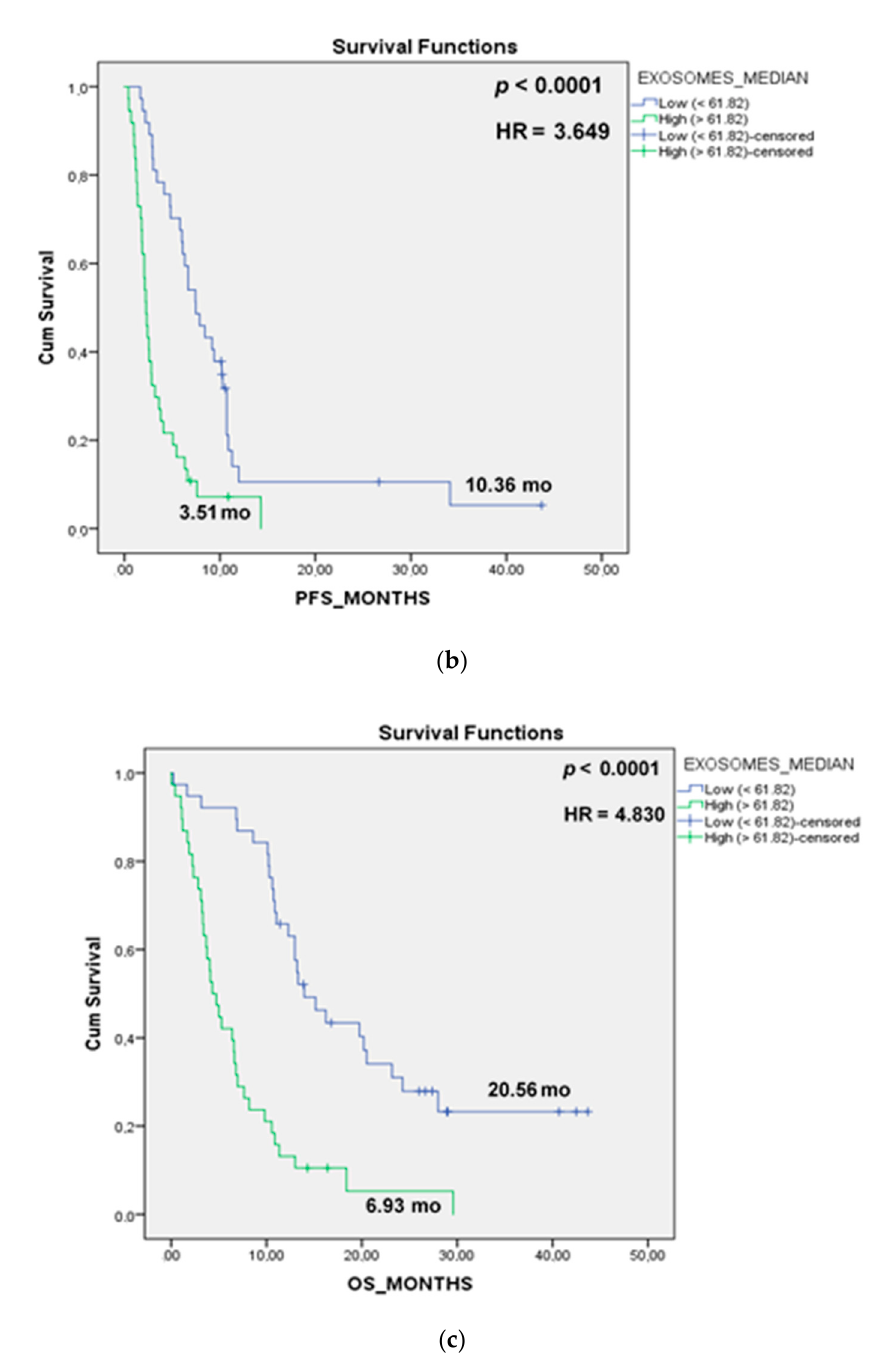
Figure 3. Prognostic significance of sEV in chemotherapy-naïve NSCLC patients. ( a ) Response to treatment in patients according to TEP levels at baseline. The levels were increased in patients with disease progression (PD, closed bars) compared with patients controlling their disease (open bars) after 3 cycles of therapy. The bars denote mean values ± SEM. Kaplan–Meier plots of ( b ) PFS and ( c ) OS in patients according to high and low TEP levels in plasma. The high TEP levels were correlated with worse PFS ( p < 0.0001) and OS ( p < 0.0001); blue line: below the median, green line: above the median (n: number of patients; PR: partial response; SD: stable disease; PD: progressive disease; PFS; progression-free survival; OS: overall survival; NSCLC: non-small-cell lung cancer; **, p < 0.01).